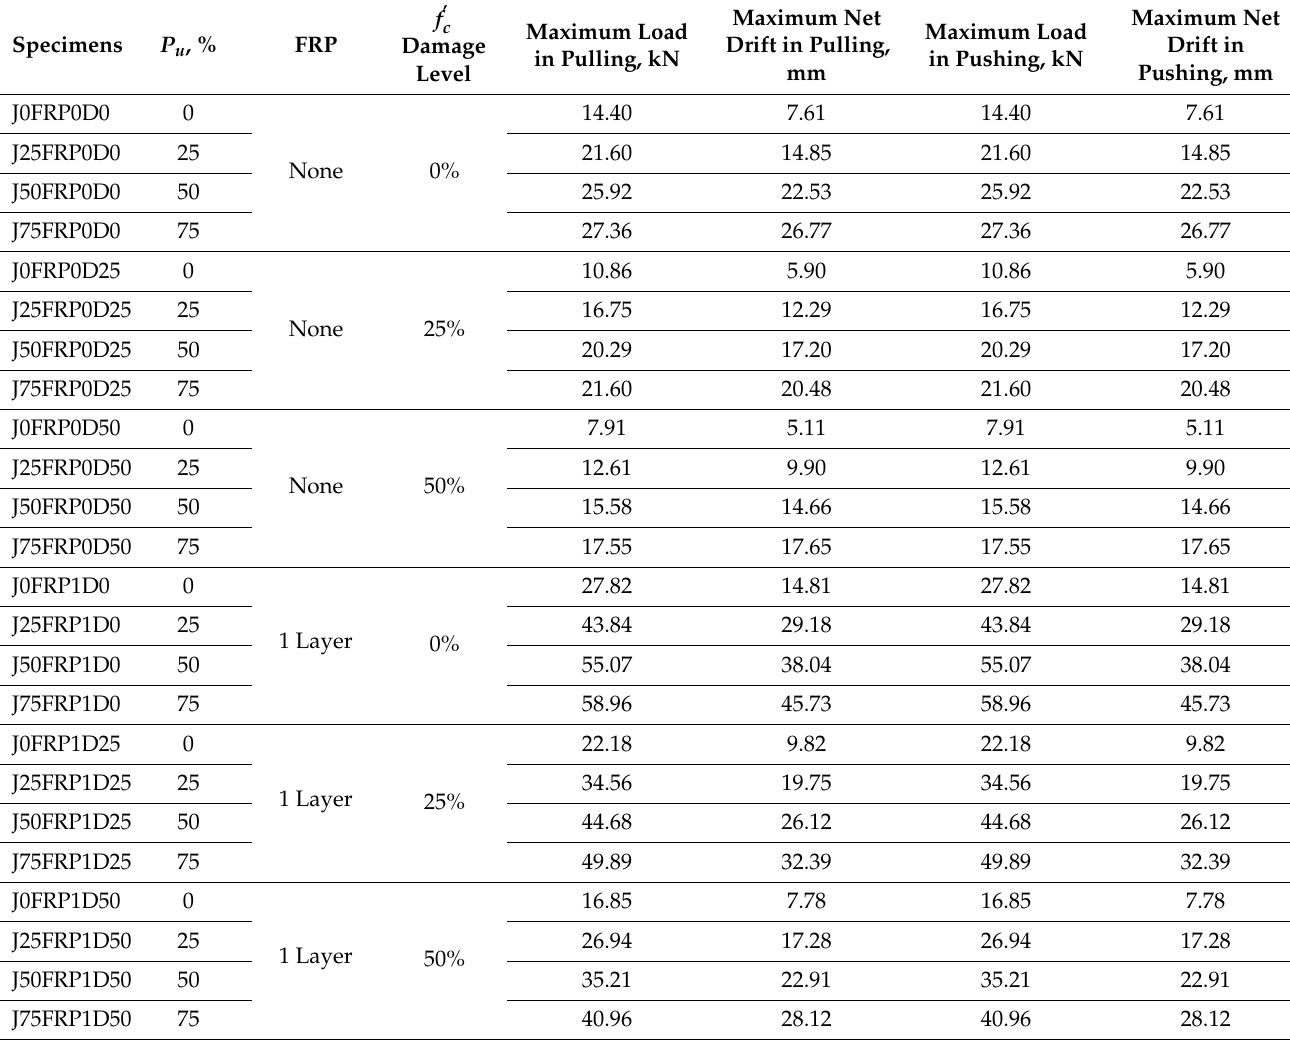
Table 1. NLFEA results of all